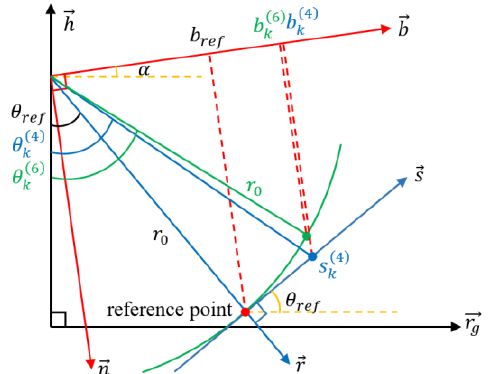
Figure 6. The frames and geometry of TomoSAR imaging model. The ground frame is in black. The radar frame of the planar wavefront model is in blue. The radar frame of the spherical wavefront model is in green. And the baseline frame is in red.